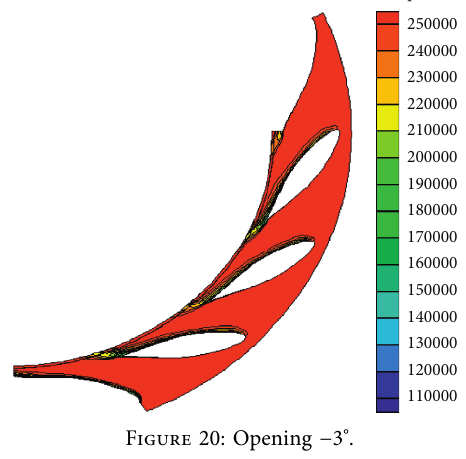
Figure 20: Opening − 3 ° .